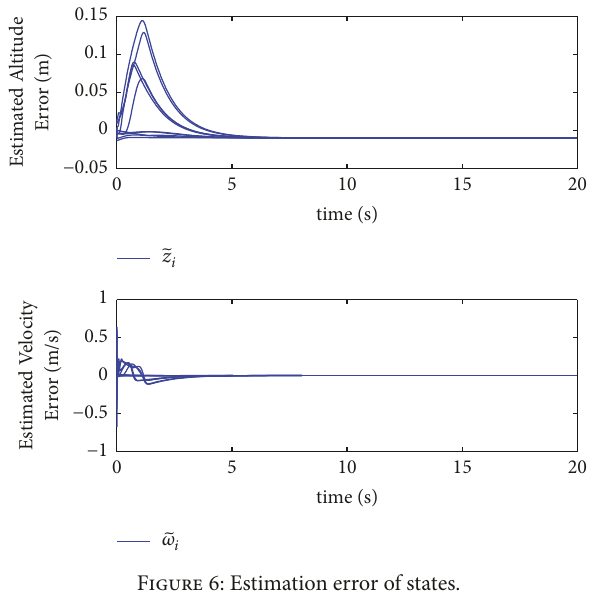
Figure 6: Estimation error of